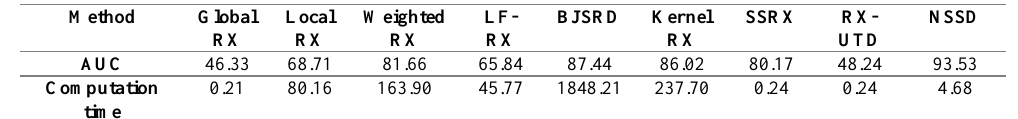
Table 1. Performance of NSSD and other anomaly detectors in terms of AUC and computation time in real AVIRIS image. AUC is area under ROC curve, where a higher value for AUC means a higher detection accuracy.